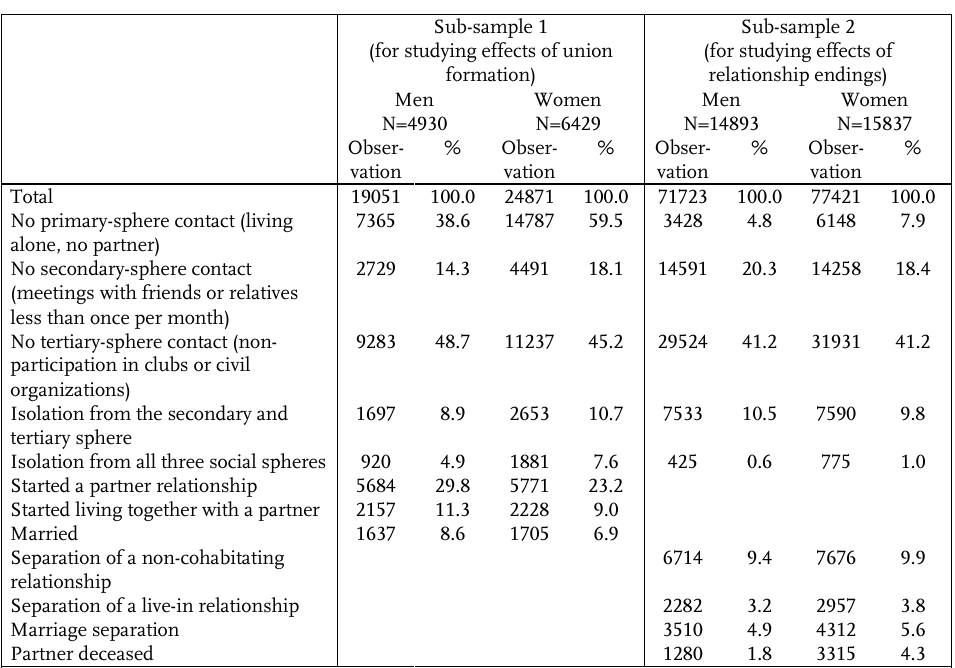
Table 1 : Description of